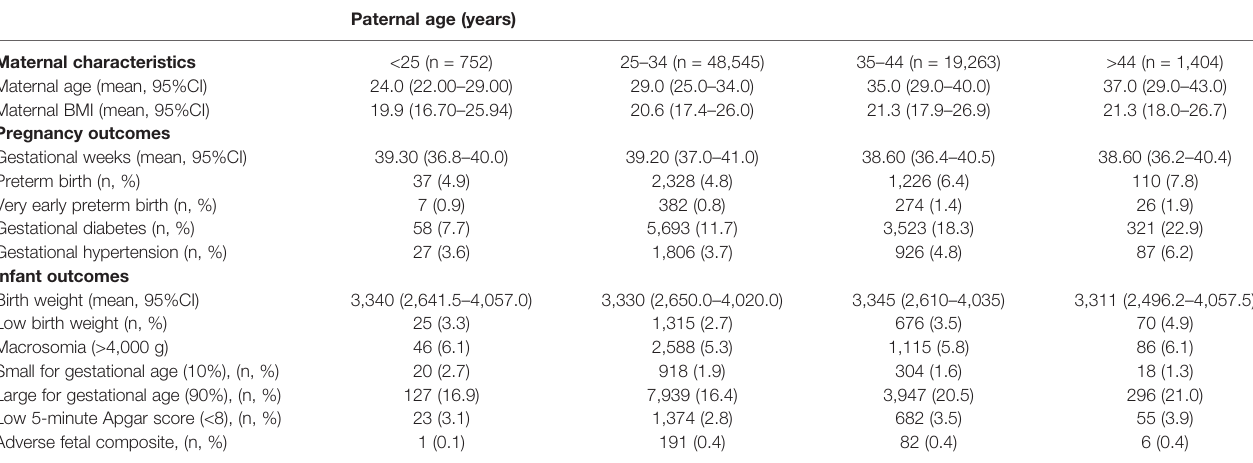
TABLE 1 | Maternal characteristics, pregnancy and infant outcomes by paternal age group.